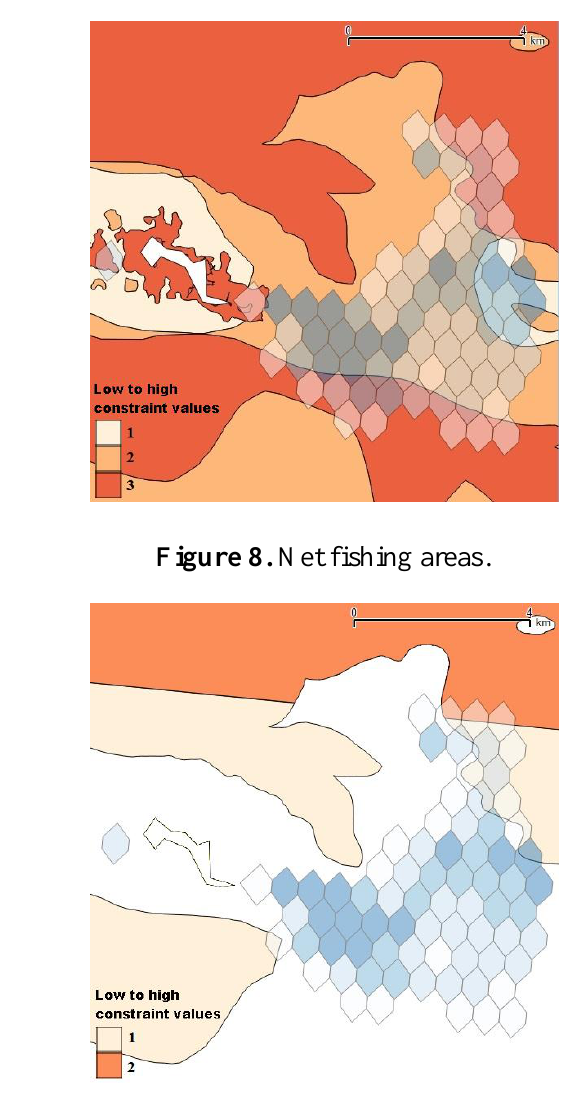
Figure 7. Floating line fishing areas.